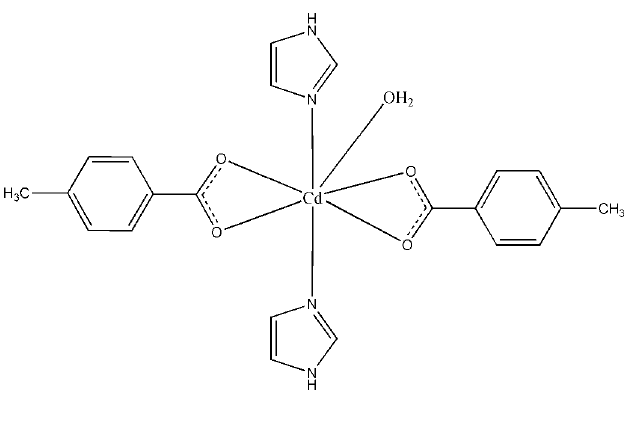
SHELXTL (Sheldrick, 2008); software used to prepare material for publication: SHELXTL . The authors acknowledge Guangdong Ocean University for supporting this